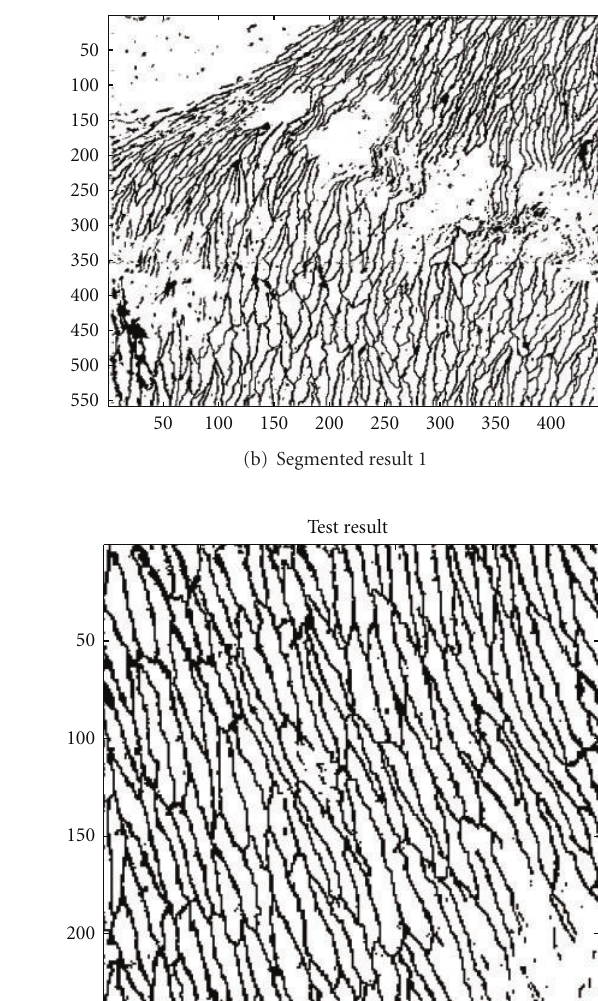
(either boundary or background) and is defined by